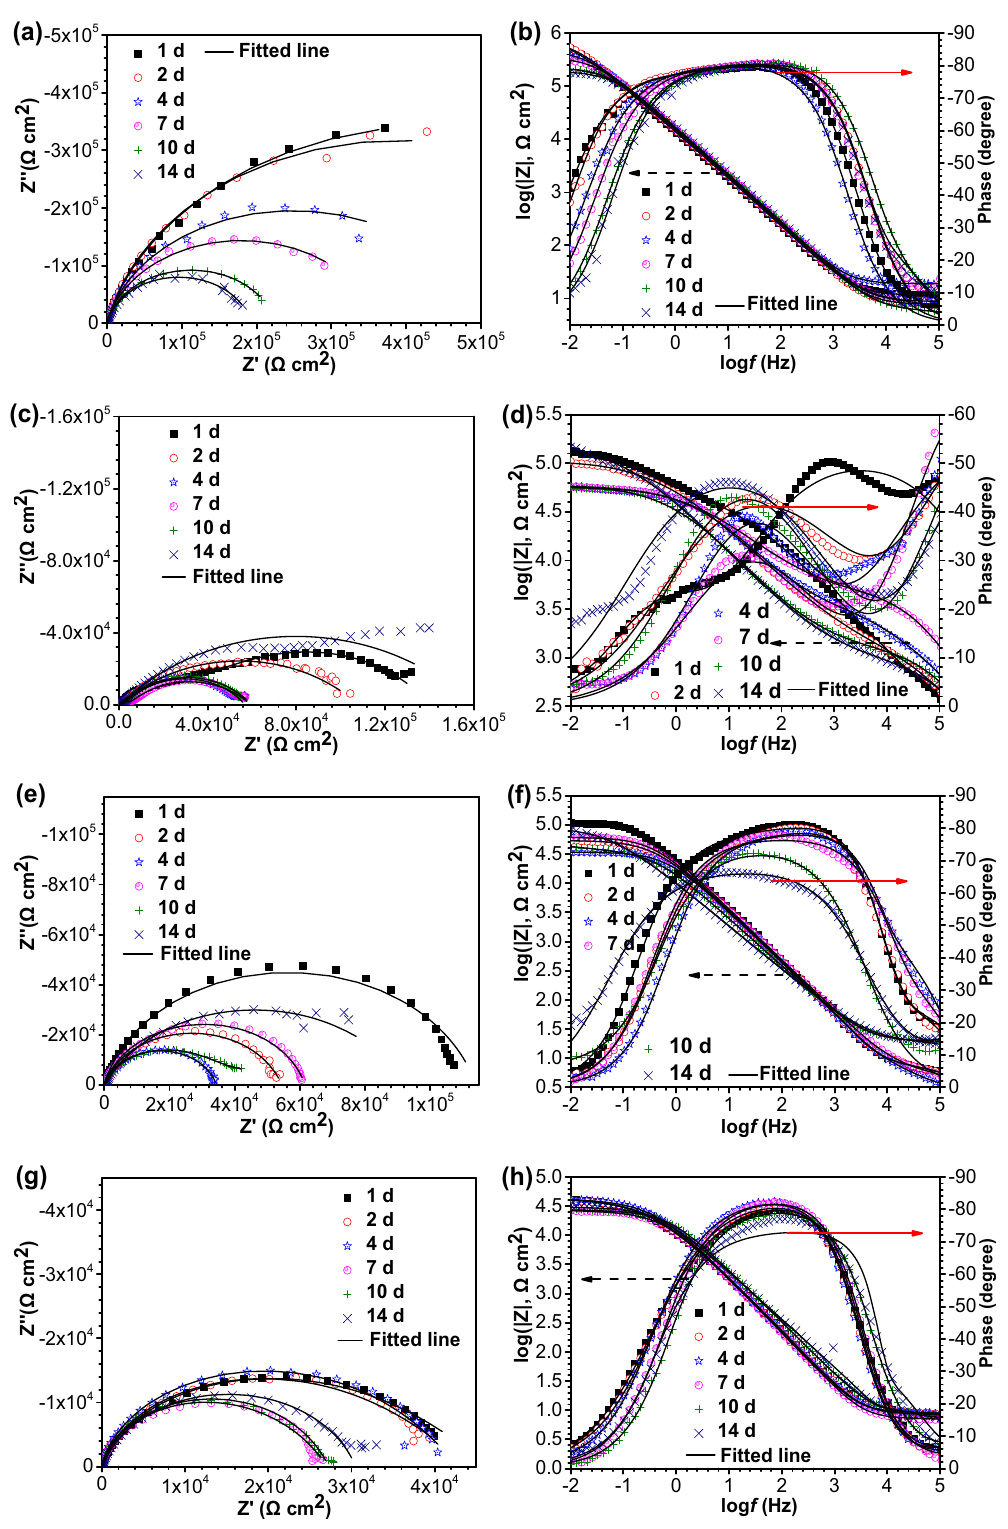
Fig. 4 Time dependent of Nyquist and Bode plots of various specimens corresponding to different initial spore concentrations of A . terreus with continued organic carbon starvation. a and b control, c and d 10 4 spores mL − 1 , e and f 10 6 spores mL − 1 , g and h 10 8 spores mL − 1